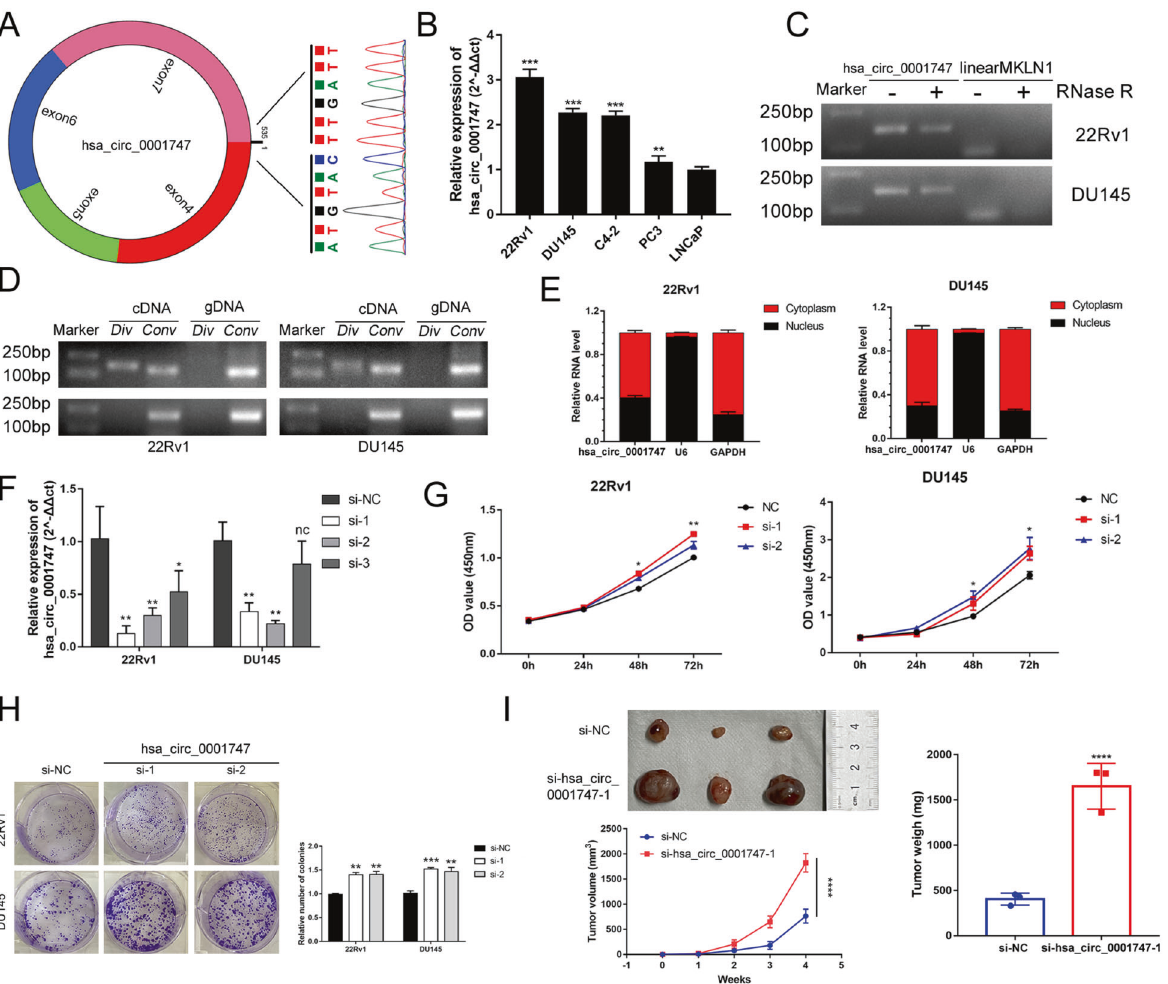
Fig. 7 Characteristics of hsa_circ_0001747 and its functional effect on PCa. A Sanger sequencing identi fi ed the back-splicing site of hsa_circ_0001747. B Basal expression level of hsa_circ_0001747 in PCa cell lines. C Hsa_circ_0001747 was resistant to RNase R digestion. D Electrophoresis con fi rmed hsa_circ_0001747 was ampli fi ed in cDNA instead of gDNA samples. E Hsa_circ_0001747 was mainly distributed in the cytoplasm in PCa cells. F RT-qPCR veri fi ed the transfection ef fi ciency of siRNAs targeting to hsa_circ_0001747 in DU145 and 22Rv1. G CCK- 8 assay veri fi ed knockdown of hsa_circ_0001747 promoted PCa cells viability. H Knockdown of hsa_circ_0001747 facilitated colony formation in PCa cells. I Knockdown of hsa_circ_0001747 promoted the subcutaneous tumor growth in nude mice. Error bar indicates mean ± SD. * P < 0.05, ** P < 0.01, *** P < 0.001, **** P <